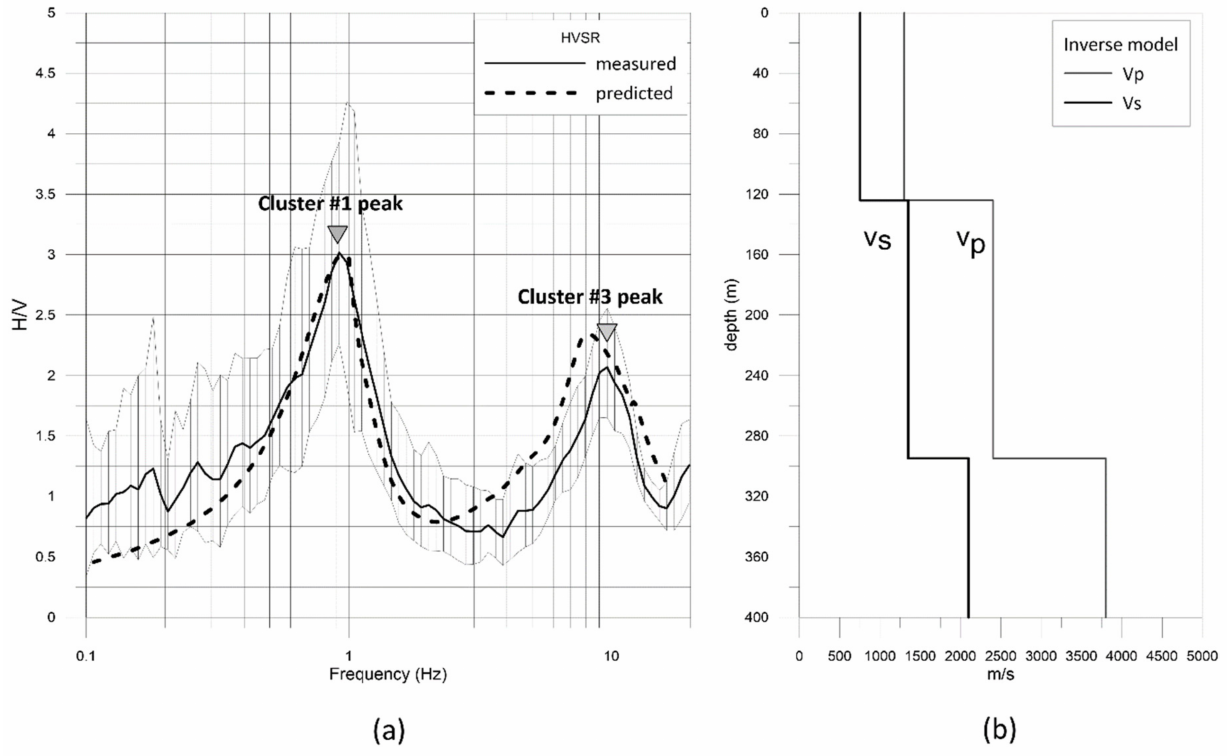
Figure 7. ( a ) HVSR curve of the measurement n. 88, in which two peaks are visible ( f 0 = 0.9 Hz; f 1 = 9.5 Hz); ( b ) inverse seismo-stratigraphic